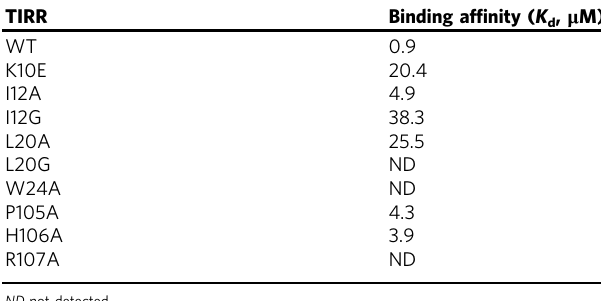
Table 2 Effects of TIRR mutation on binding of 53BP1 Tudor